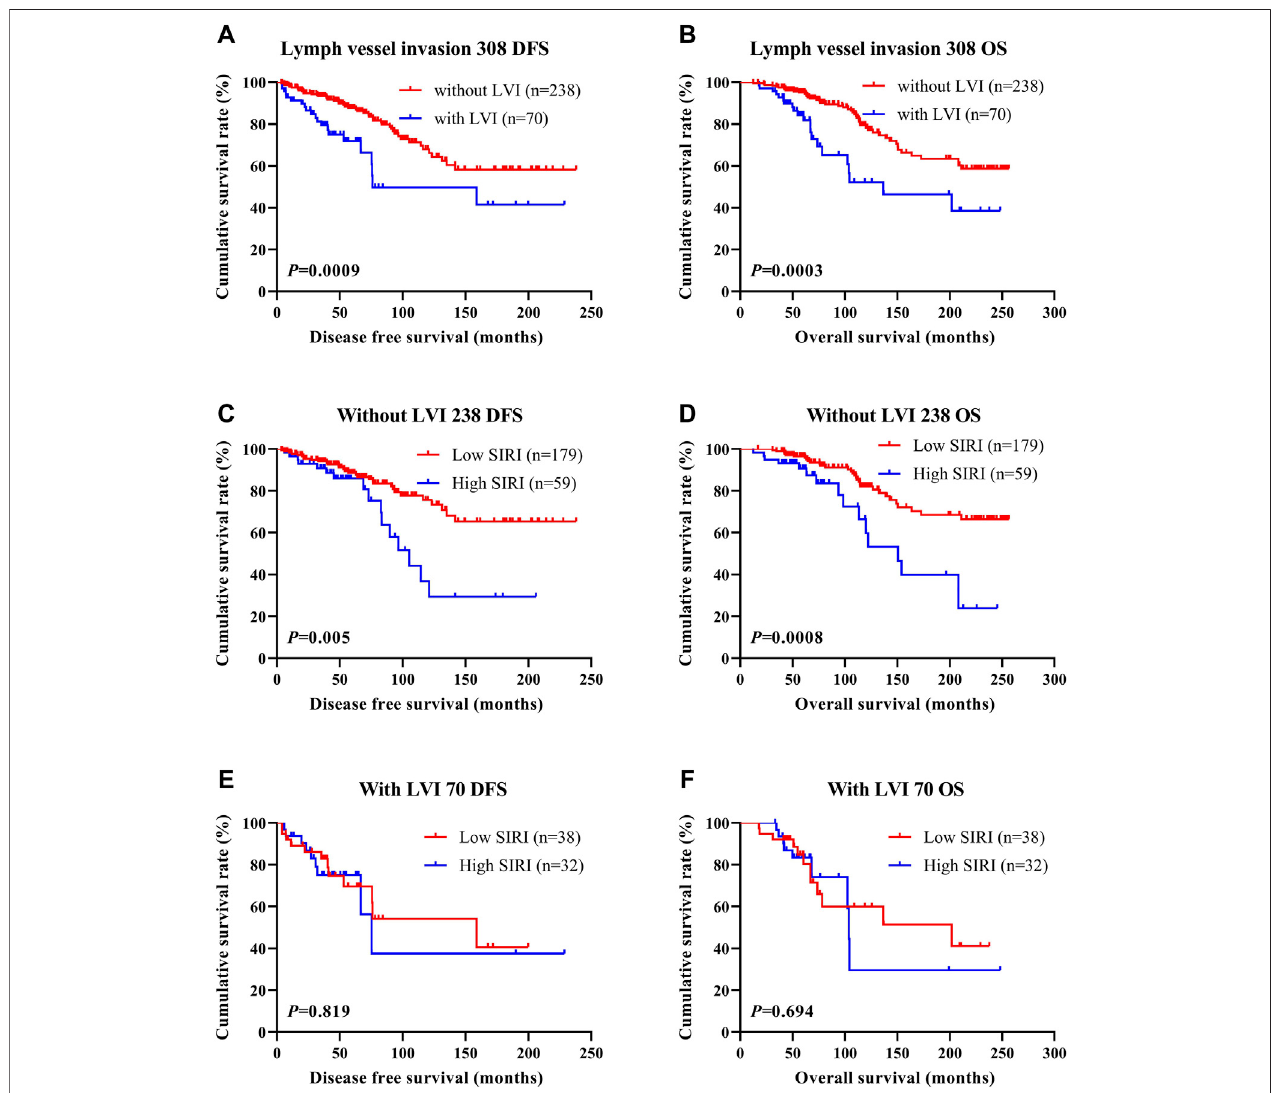
FIGURE 8 | DFS and OS based on the presence of lymph vessel invasion in breast cancer patients (non-NACT group). (A) Kaplan-Meier analysis of DFS for the SIRI of all patients with breast cancer. (B) Kaplan-Meier analysis of OS for the SIRI of all patients with breast cancer. (C) Kaplan-Meier analysis of DFS for the SIRI of breast cancer patients without lymph vessel invasion. (D) Kaplan-Meier analysis of OS for the SIRI of breast cancer patients without lymph vessel invasion. (E) Kaplan-Meier analysis of DFS for the SIRI of breast cancer patients with lymph vessel invasion. (F) Kaplan-Meier analysis of OS for the SIRI of breast cancer patients with lymph vessel invasion.